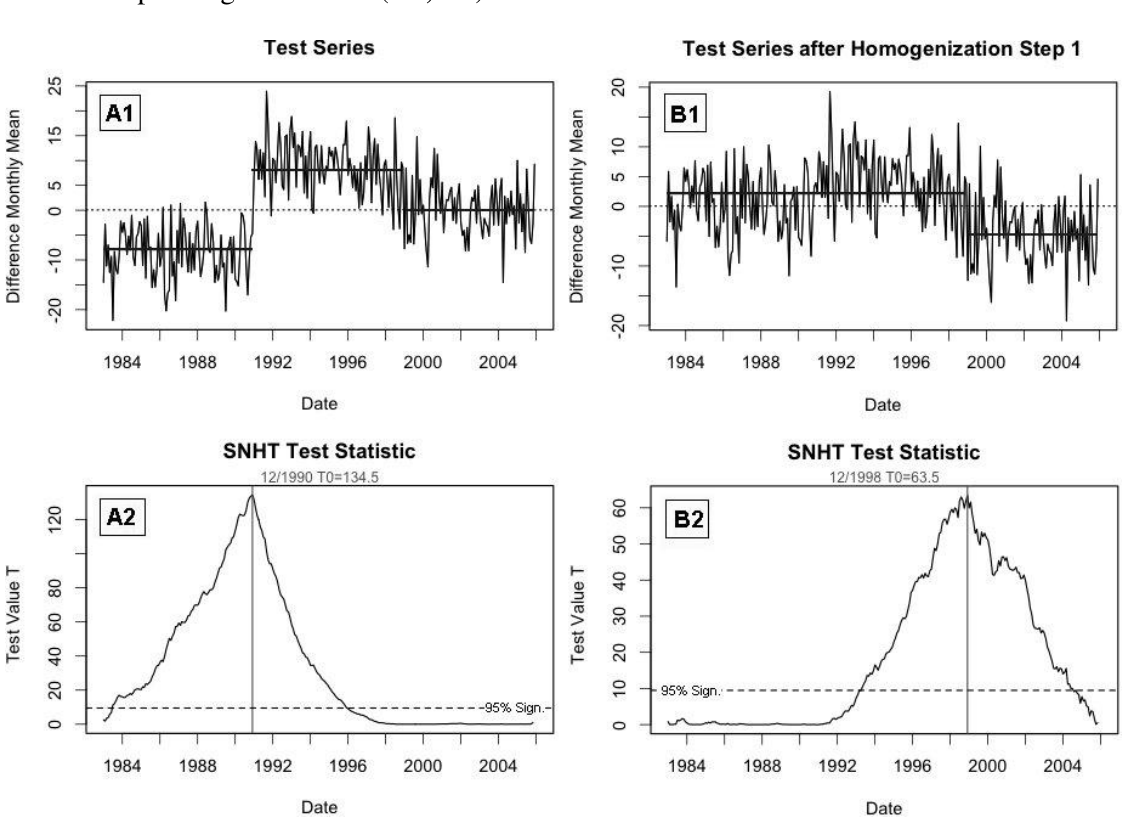
Figure 2. Synthetic time series with two breaks ( A1 ), after the first homogenization step ( B1 ) and corresponding T statistics ( A2, B2